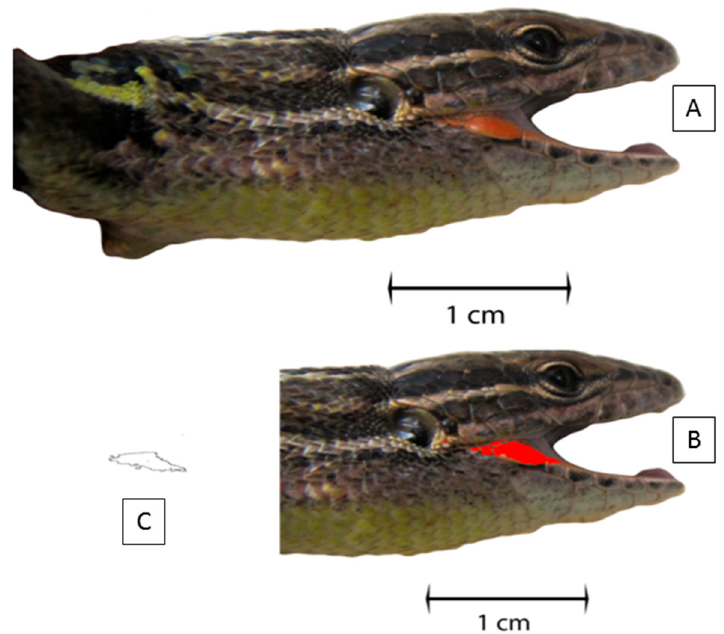
Figure 2. Representation of procedures for quantifying the coloured commissure area, using the software Image J (version 1.60). ( A ) First, we performed lateral photographs of the lizard with the mouth opens; ( B ) Second, we selected the coloured area with the “Colour threshold” tool; ( C ) Third, we measured the area with the “Analyse particles” tool.